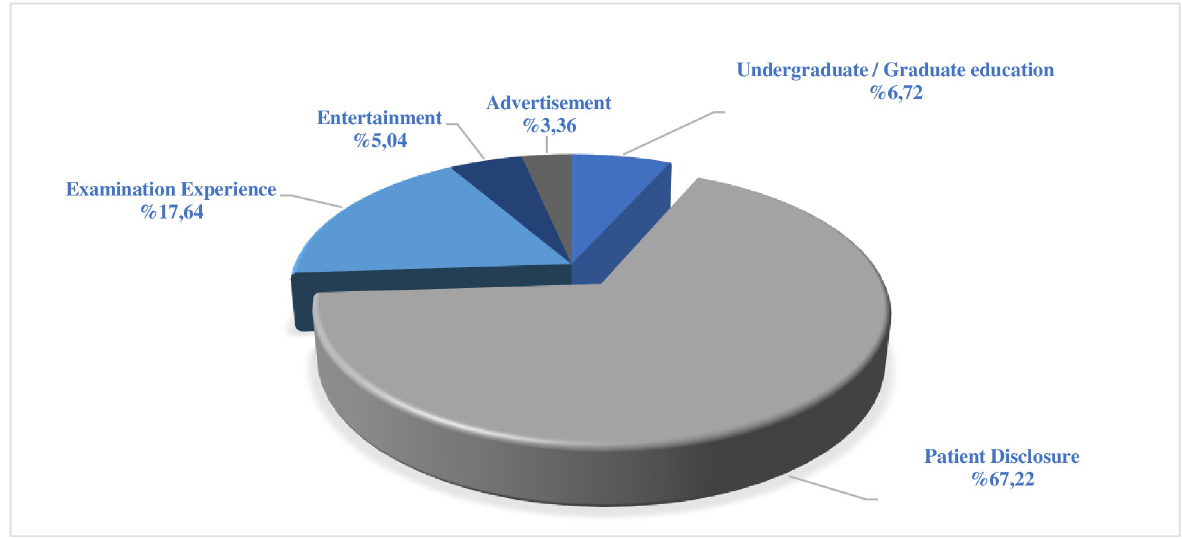
Fig 2. Classification of YouTube videos about pediatric dentistry according to their content.